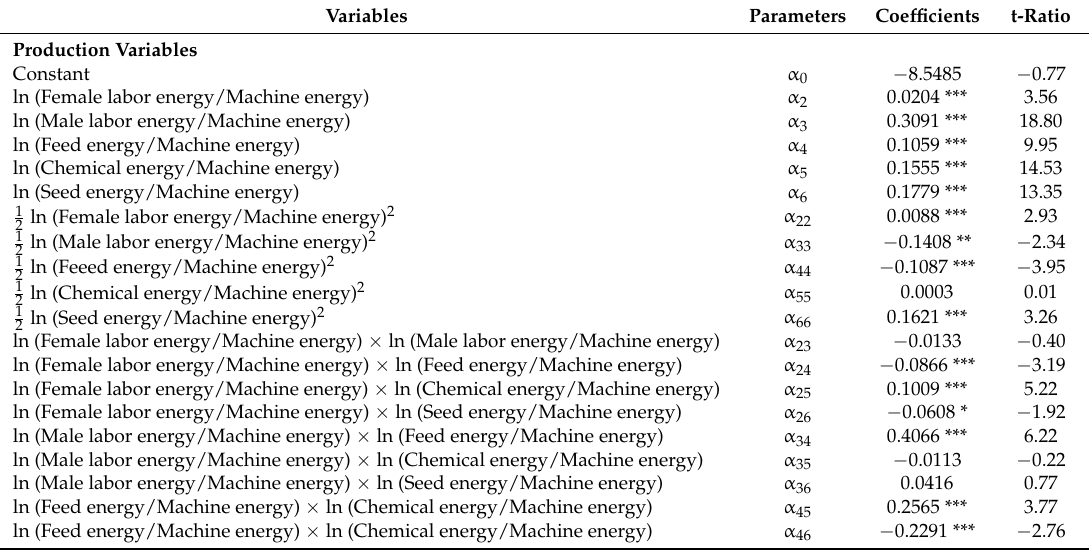
Table 5. Parameter estimates of the stochastic input distance function including inefficiency